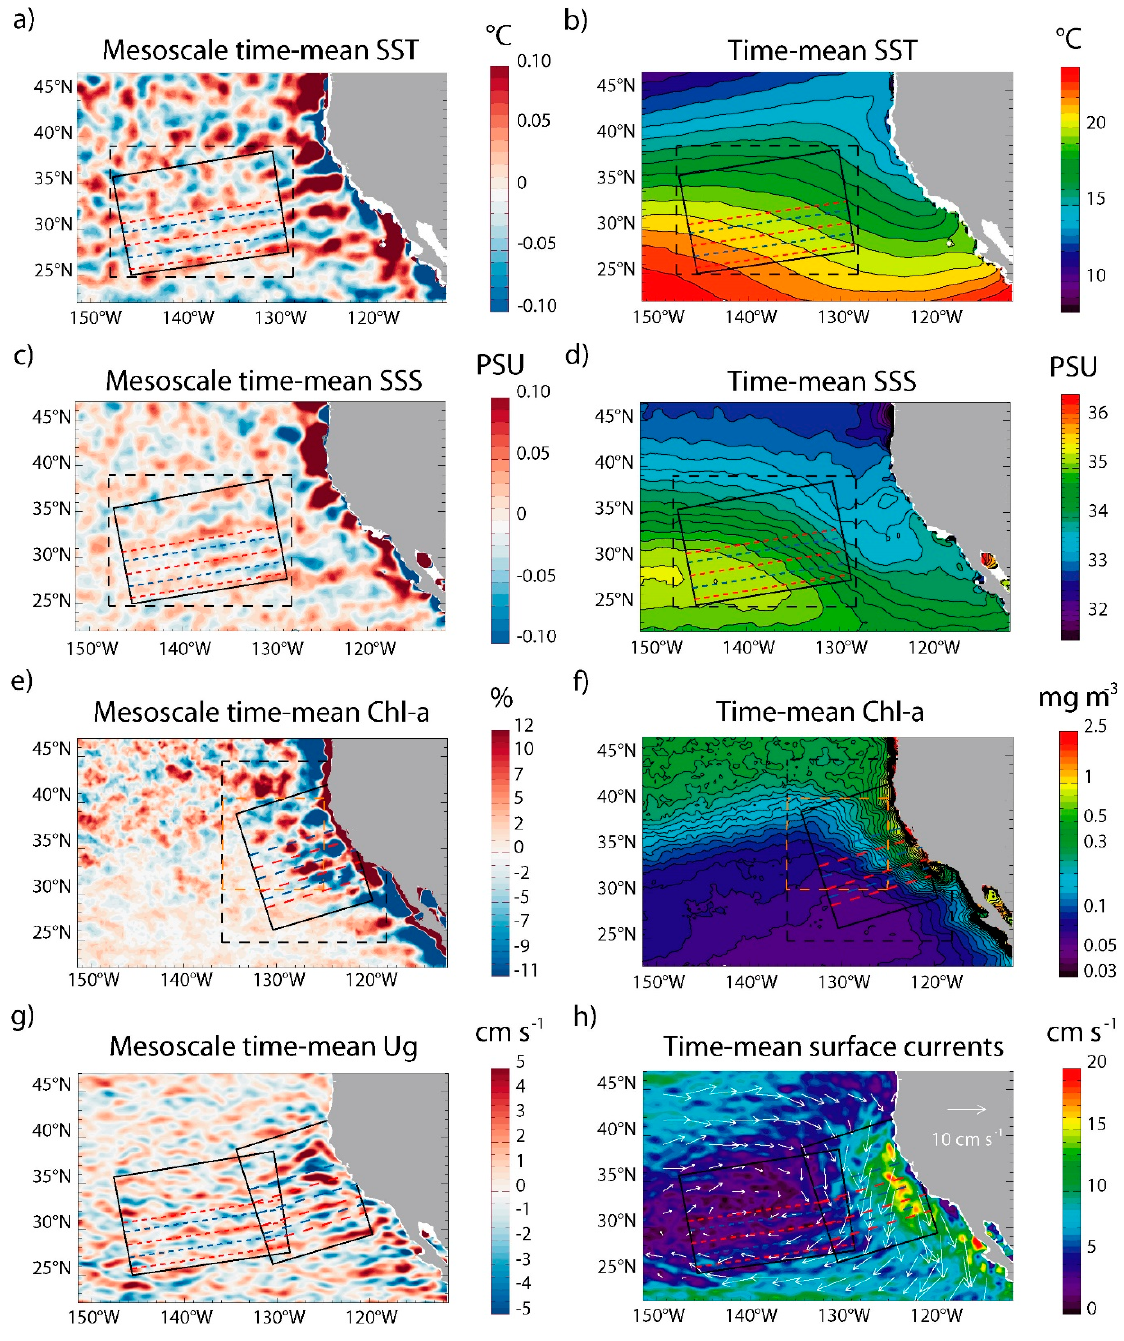
Figure 2. Striation expressions in physical/biological tracers and currents in the ENP: mean ( a , c , e , g ) spatially high-pass filtered and ( b , d , f , h ) full ( a , b ) AMSR-2 SST (°C), ( c , d ) SMAP SSS (PSU), and ( e , f ) GlobColour Chl-a; ( g , h ) mean ( g ) spatially high-pass filtered SSALTO/DUACS U g (cm s − 1 ) and ( h ) GlobCurrent full surface current velocity (shading, cm s − 1 ) and vectors. Chl-a units are mg m − 3 for ( f ), the full field, and % of the latter for ( e ), the high-pass filtered field (Appendix A). The black dashed boxes are where 2-D FFT is applied to the tracer fields and U g , except for ( e , f ) Chl-a, for which the orange dashed box is used. The solid boxes are tilted with the striation angle in SSALTO/DUACS U g determined from 2-D FFT. The associated tilted red and blue dashed lines on all the panels indicate the approximate locations of eastward and westward jets, respectively, as inferred from ( g ) SSALTO/DUACS U g . The 2 July 2012–31 December 2018 averaging period is considered throughout, except ( c , d ) where the 4 April 2015–31 December 2018 period is used due to the shorter SSS record, resulting in a slightly larger striation tilt (9.7° vs. 8.8°, see Table 1).